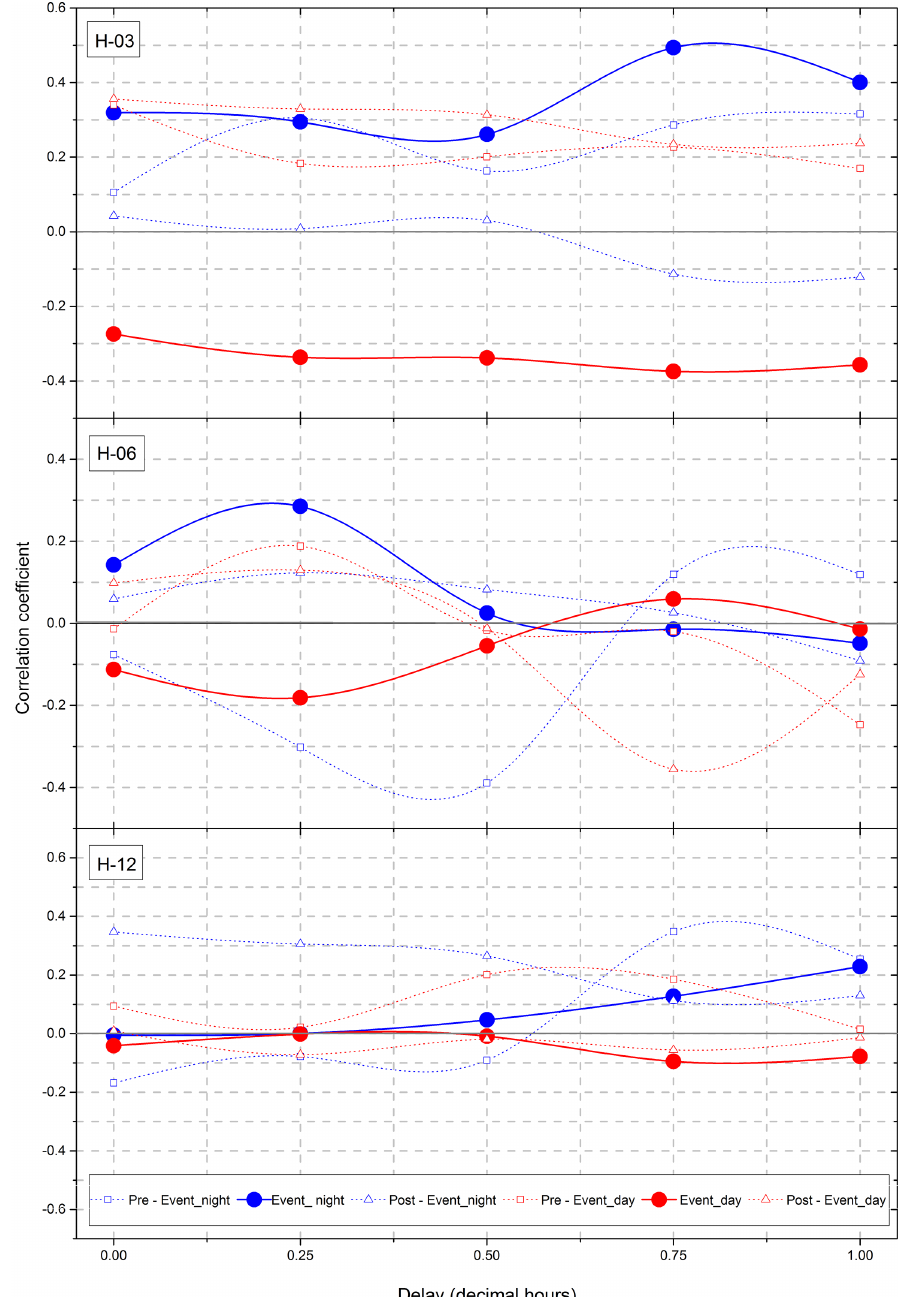
Figure 4. Correlation analysis for three HILDCAA events using two time intervals representative of day (10 to 12LT) and night (2 to 4LT) periods. The red lines represent the event during the daytime, while the blue lines represent it during the nighttime. The dashed lines represent pre-event (rectangle) and post-event (triangle), and the solid line represents the event